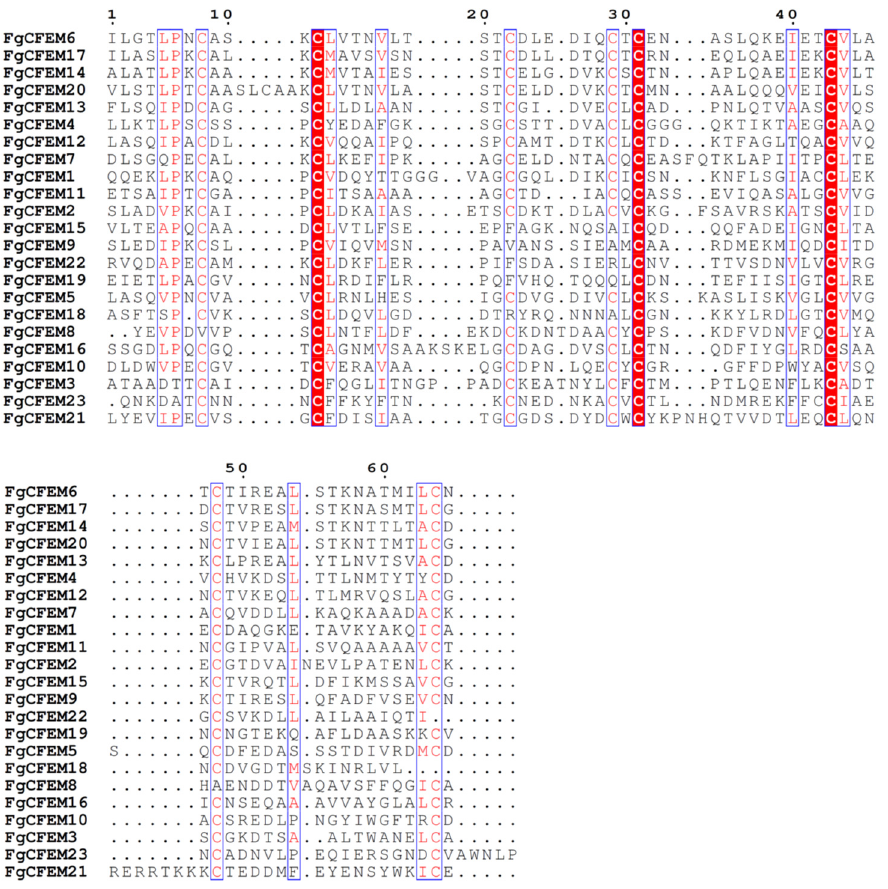
Figure 2. Multi-sequence alignment of the CFEM proteins in F. graminearum. The alignment was performed using ClustalW program, and the conserved amino acids are highlighted in red color. Red color font: conserved AA in some but not all the FgCFEMs, red color background: conserved AA in all the 23 FgCFEMs.